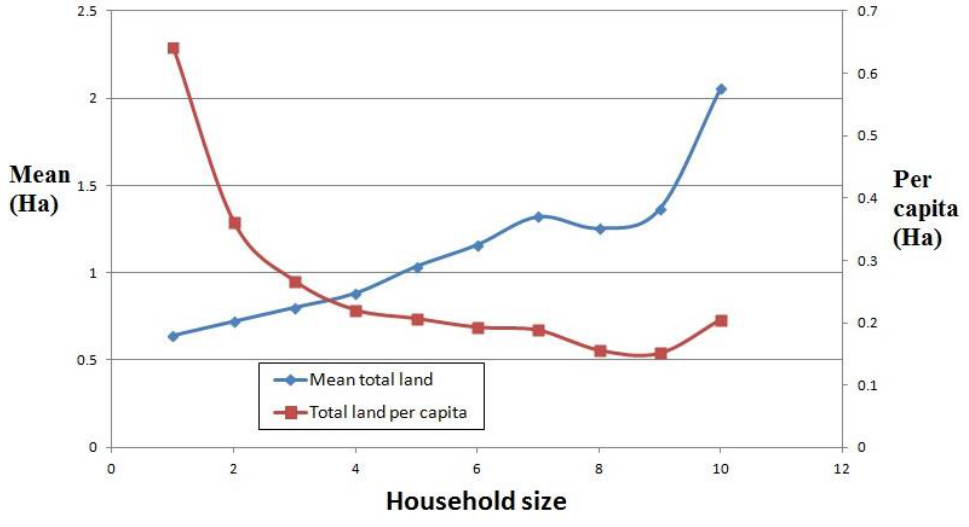
Figure 5. Mean total land and total land per capita distribution per household size in Malingunde EPA.